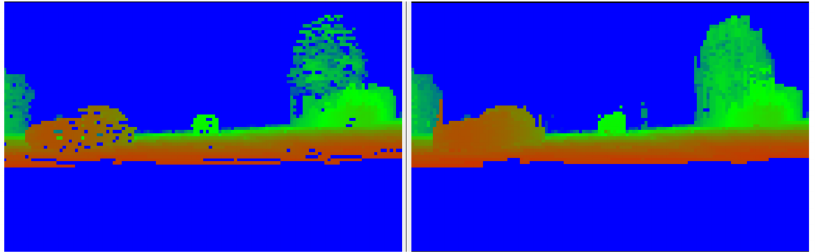
Figure 11. Low resolution depth map and its corrected version - scene depicts a car close by on the left, a car in the middle farther away and foliage on the right. Color encodes the distance from red (close) to blue (far), up to 20 m. Positions with no measurements default to